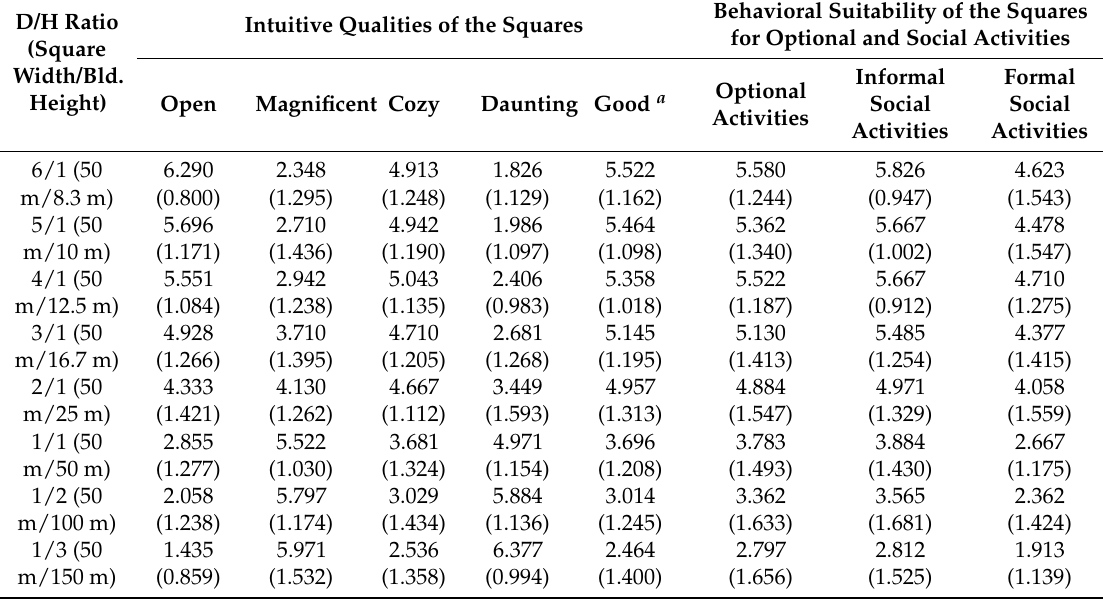
Table 4. Means and standard deviations of scores for eight dependent variables by the D/H ratio. D/H Ratio (Square